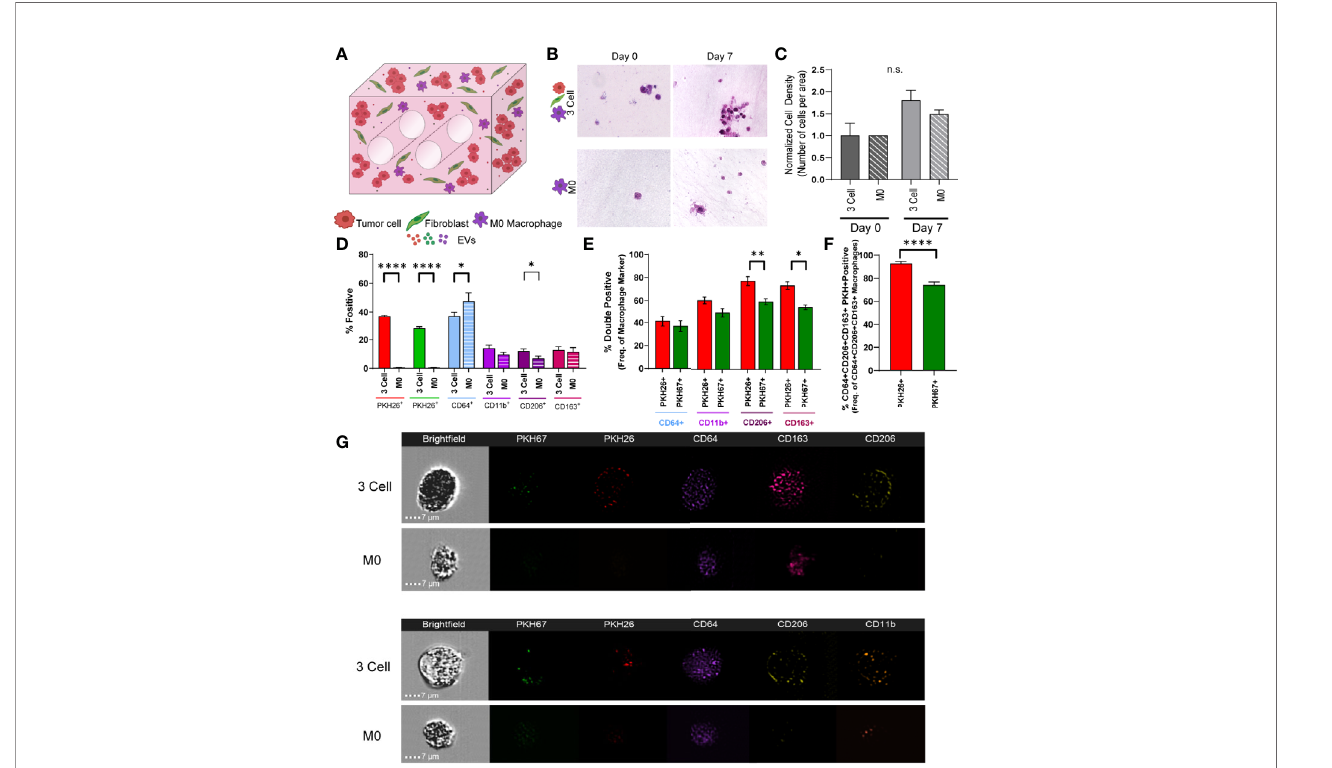
FIGURE 5 | Tumor Cells and Stromal Fibroblasts Polarize M0 macrophages within an Immune Cell Reconstituted Model of Lung Carcinoma. (A) Schematic showing immune cell reconstituted model (3 Cell) containing tumor cells (red), fi broblasts (green), and M0 macrophages (PMA activated THP-1, purple). (B) Representative photomicrographs showing cell density within 3 cell tumor mimics (top) over time, compared to models containing only M0 macrophages (bottom). (C) Quanti fi cation of cell density, normalized to day 0. (D) Characterization of cell populations within 3 cell and bioreactors containing M0 macrophages showing increased CD206 + cells within 3 Cell bioreactors compared to bioreactors containing M0 macrophages only following 7 days culture. (E) Characterization of M0 macrophages containing tumor derived material (indicated by PKH26 signal) or fi broblast derived material (indicated by PKH67 signal) showing a signi fi cant increase in the PKH26 + CD206 + and CD163 + cell populations. (F) M2 like macrophages (CD64 + CD163 + CD206 + ) contain more tumor cell-derived material (indicated by PKH26 signal). n=3-6 replicates per condition. (G) Representative imagestrips showing PKH signal within M0 macrophages. ns, not signi fi cant, *p<0.05, **p<0.01,